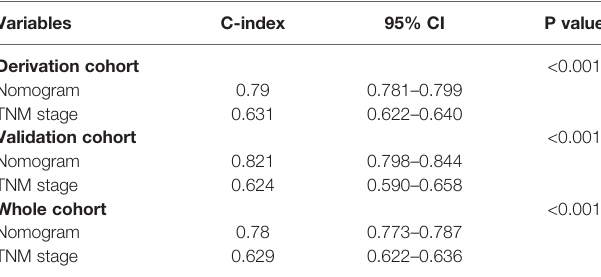
TABLE 6 | Comparison between nomogram and TNM classi fi cation in RSCC.